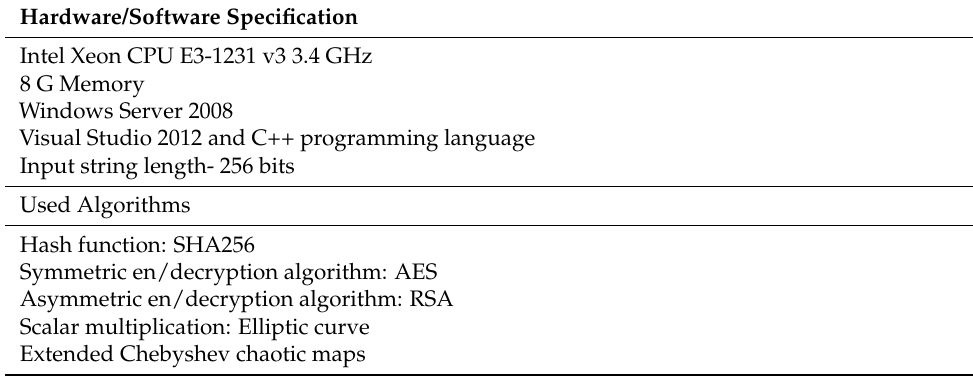
Table 4. Simulation environment.